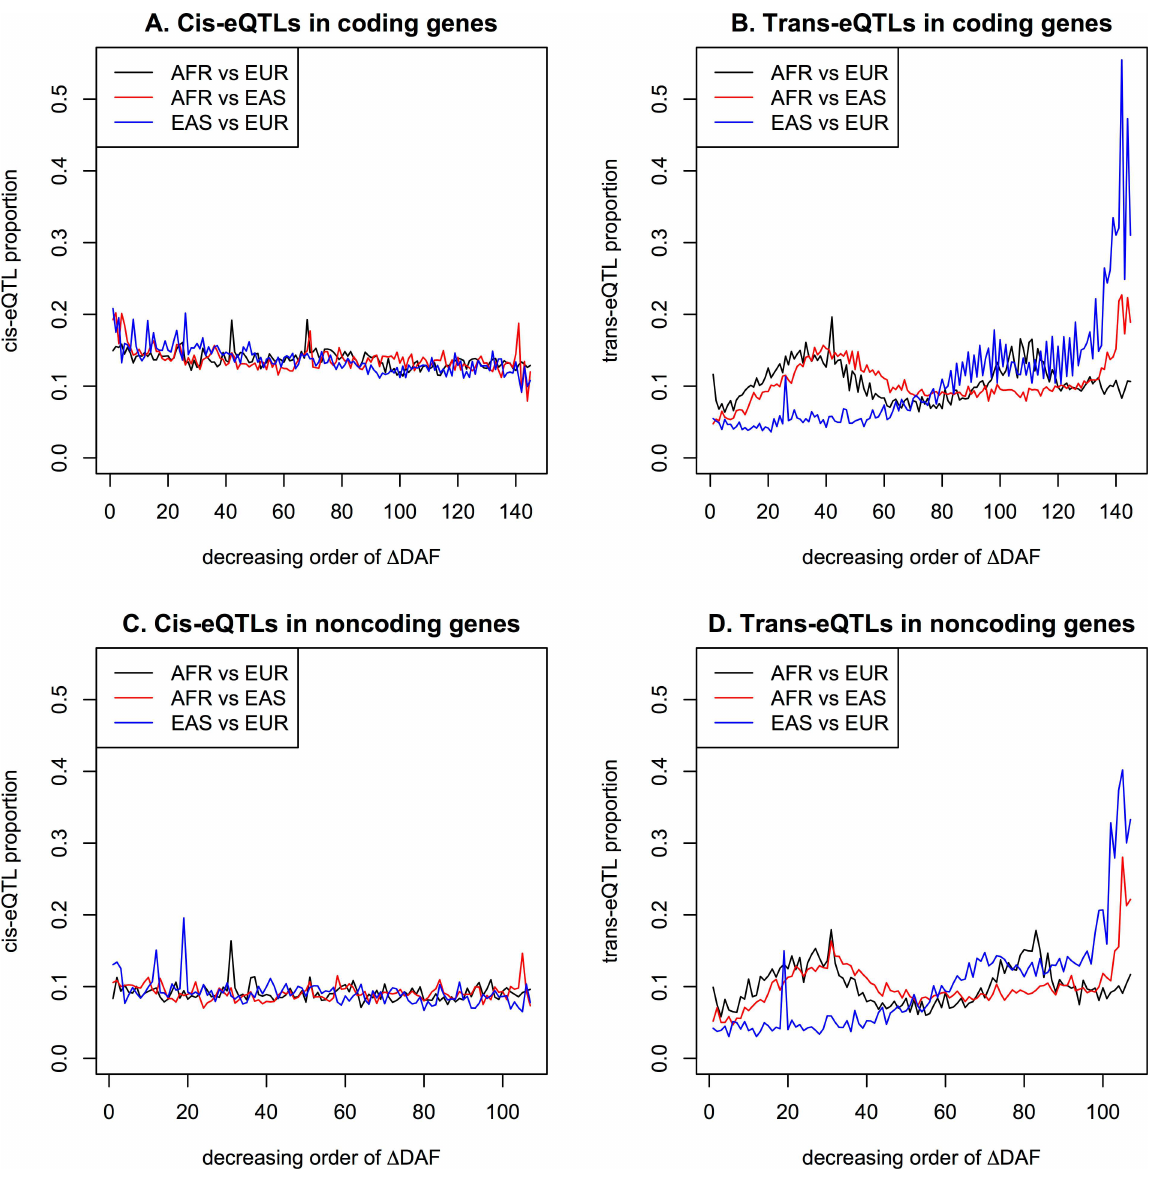
Fig 4. Proportions of eQTLs in groups with decreasing Δ DAF: (a) cis-eQTLs in coding genes; (b) trans-eQTLs in coding genes; (c) cis-eQTLs in noncodinggenes; (d) trans-eQTLs in noncoding genes.